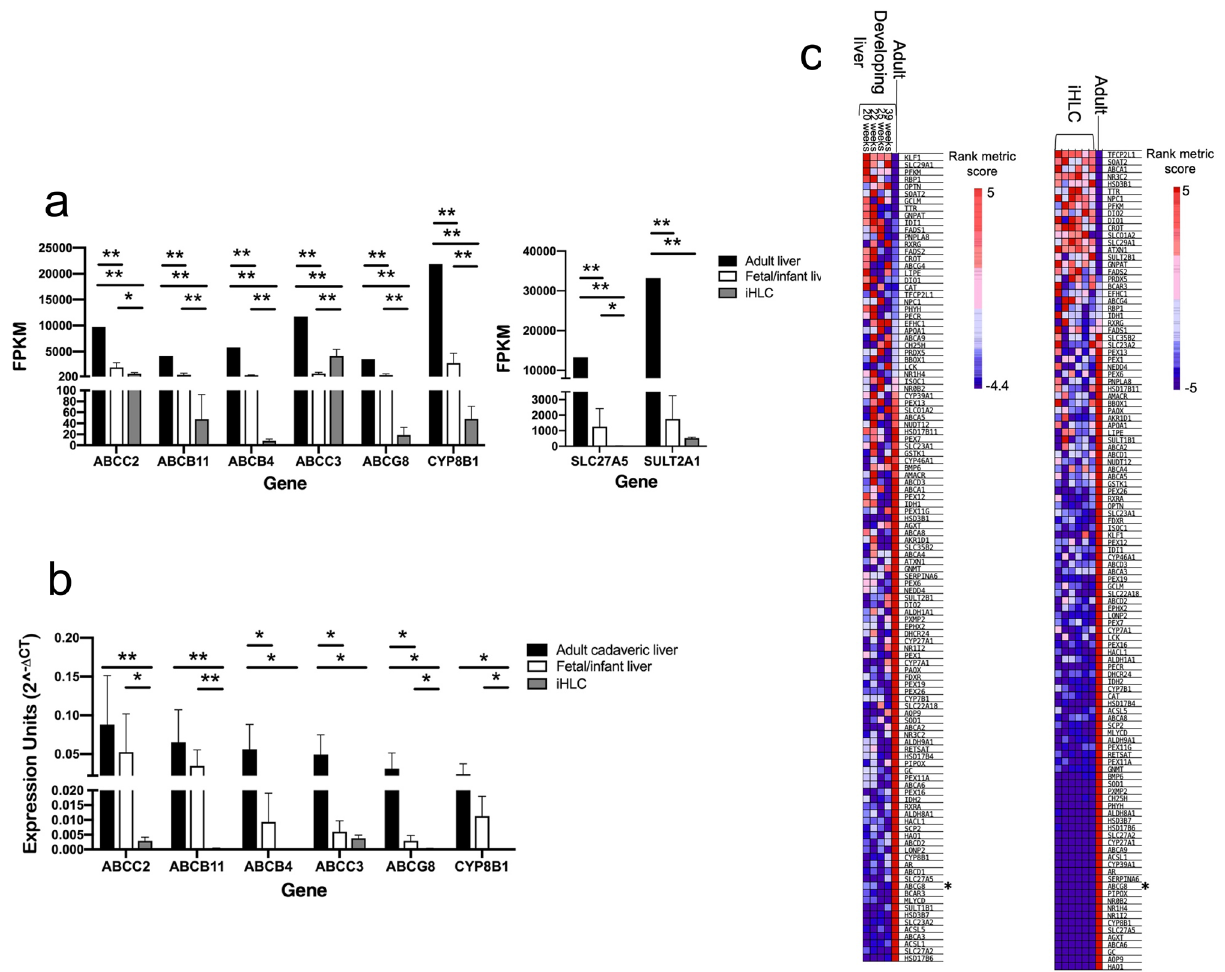
Figure 2. Gene expression differences in bile acid and sterol metabolism in human developing liver, iHLC, and adult liver. ( a ) Bar graphs showing expression of bile acid and sterol metabolizing genes that were among the most differentially expressed in the fetal/infant liver samples (white) and iHLC (gray), compared to adult liver (black) by RNA-sequencing. ( b ) Bar graph showing mRNA levels, by real-time qRT-PCR, of select bile acid transporters and sterol metabolizing genes in the fetal/infant samples (white) and iHLC (gray), compared to six adult cadaveric liver samples (black). Expression units (2 -ΔCT ) was calculated relative to the housekeeping reference gene, β-actin. N = 3 biological replicates each for iHLC. The bar indicates the mean and error bar indicates standard deviation (SD) for FPKM ( a ) and expression units ( b ). * P -value < 0.05, ** P -value ≤ 0.01. ( c